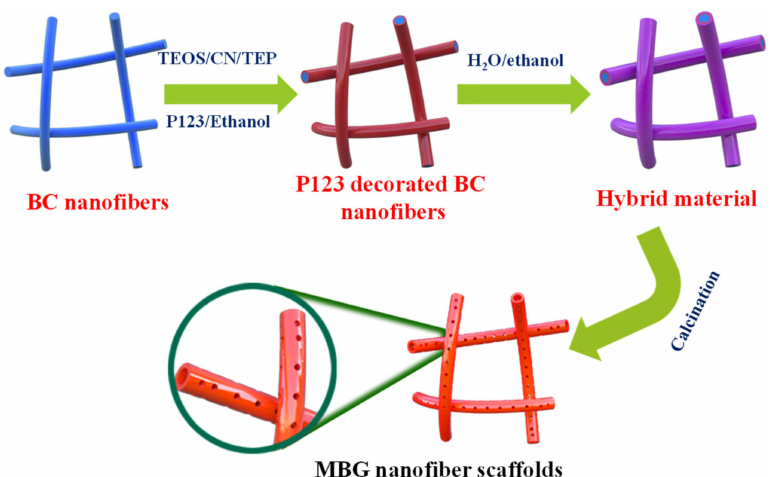
Figure 1. Schematic illustration of the synthesis of MBG nanofiber